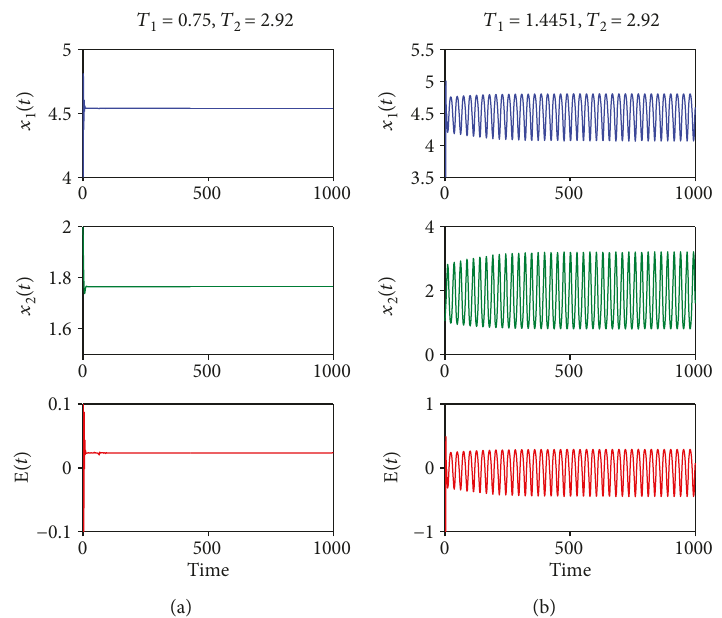
= 1 , m = 2 , r = 0 3 , a = 2 , w = 5 , c = 1 , and v = 0 5 . 1 2 2 2